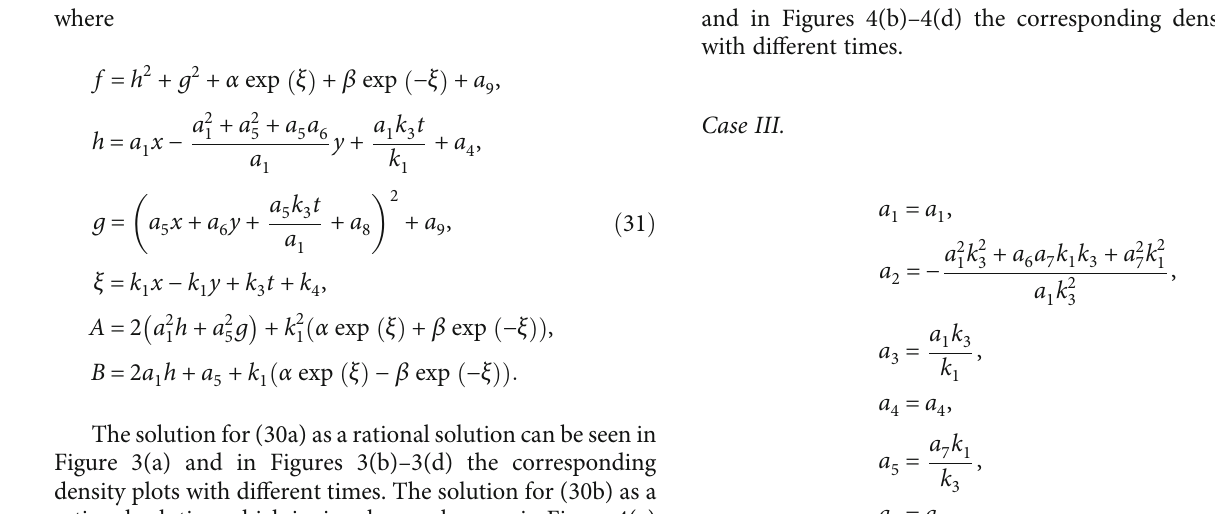
Figure 5: Pro fi les of the solution u via (35a) and pro fi les of the solution v via (35b) with a k 1 = 1 , k 3 = 2 , and k 4 = 0 . (a) and (c) are the 3-dimensional plots; (b) and (d) are the corresponding density